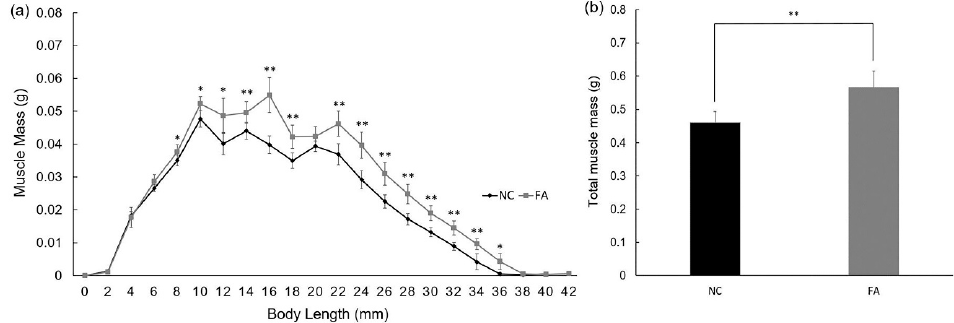
Figure 2. Effects of ferulic acid on muscle mass of adult zebrafish. ( a ) Muscle mass contained per slice in each group. Computed Tomography (CT) scan was taken every 2 mm from head to tail; ( b ) Average muscle mass in total for each group. Data are expressed as mean ± SD ( n = 5 per group from Population 1), * p < 0.05, ** p < 0.01 compared with the NC group.